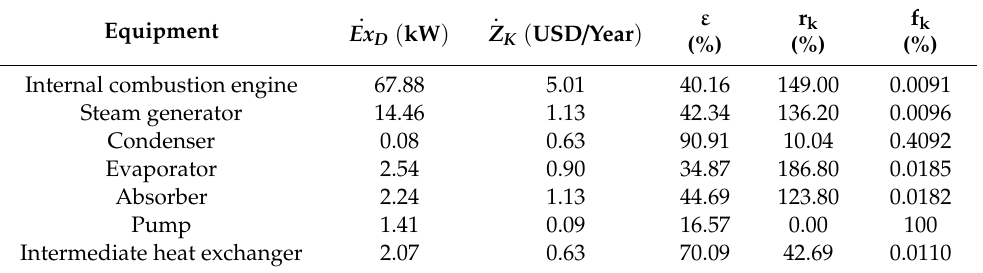
Table 5. Exergoeconomic parameters.